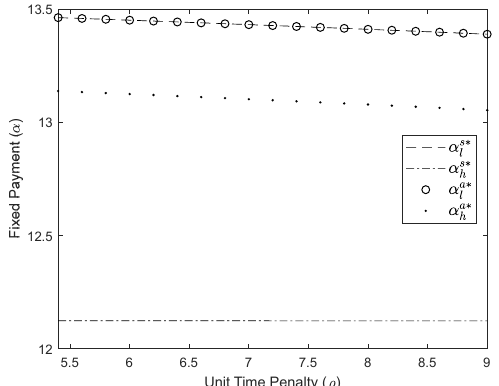
Fig. 7. The penalty coefficient in the symmetric and asymmetric scenario